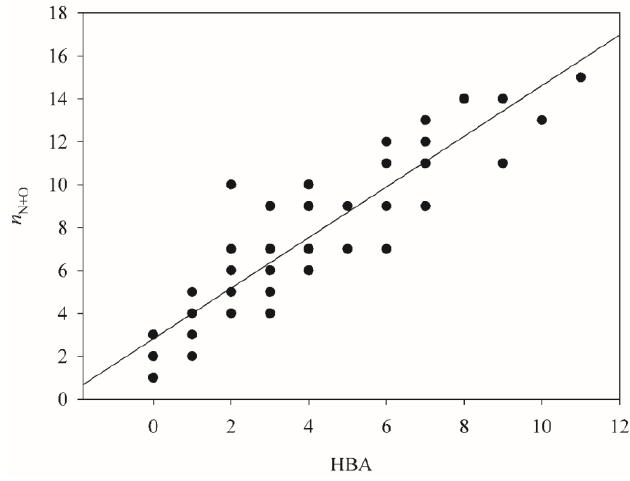
Figure 9. The number of nitrogen and oxygen ( n N+O ) vs. HBA.